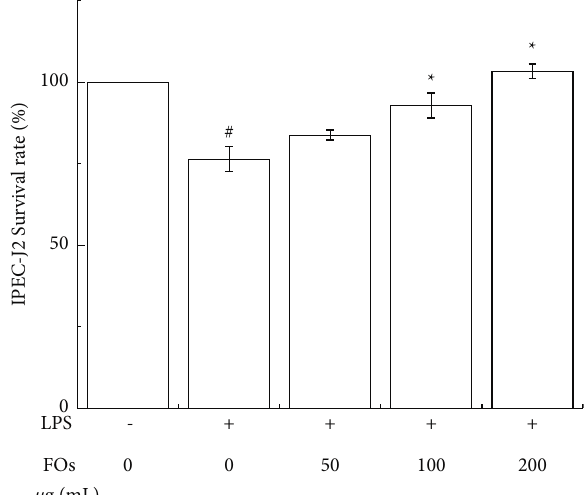
Figure 1: The effects of various concentrations of FOs-FWB on survival rate of LPS-stimulated IPEC-J2 cells. The data are expressed as the mean ± SE ( n � 3). # Indicates significant differences from control. ∗ Indicates significant differences from LPS. FOs-FWB: feruloyl oligo- saccharides from fermented wheat